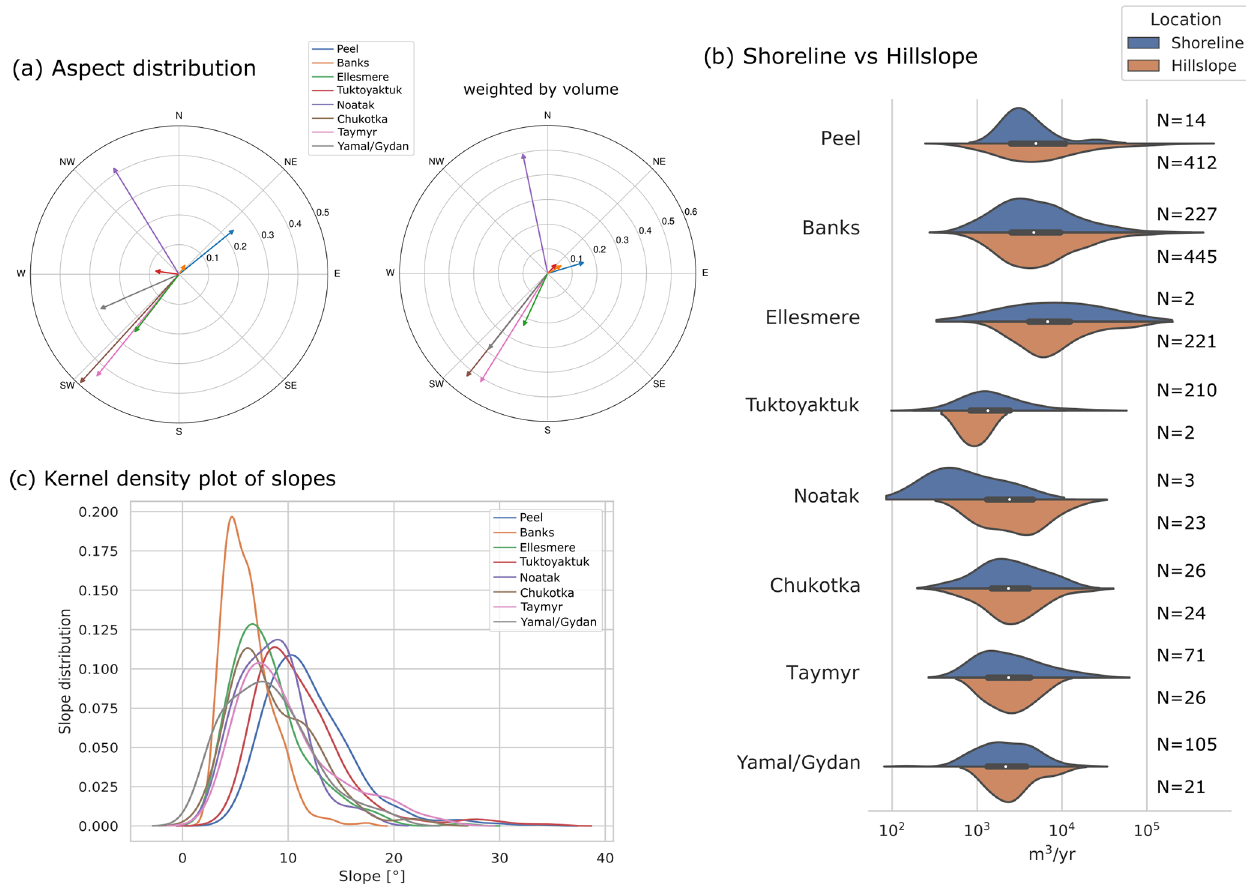
Figure 7. Terrain controls of mapped RTSs for each study site. Panel (a) shows the aspect main orientation of RTSs in each study site (left) and this additionally weighted by the volumetric change rates (right). Panel (b) shows the probability density distributions of volumetric changes rates in the form of violin plots. For each violin plot the white dot on the centre line indicates the mean value of the entire study site dataset, with the thick centre line showing the interquartile range. However, the top part of each violin indicates the probability density of the subset of shoreline RTSs, whereas the bottom part indicates the probability densities of the subset of hillslope RTSs, and the data across the distributions of values are smoothed by a kernel density estimator. The number of RTSs in each subset is listed on the right. Some sites are dominated by one location type. Panel (c) shows the distribution of the pre-disturbed DEM slopes at the RTS